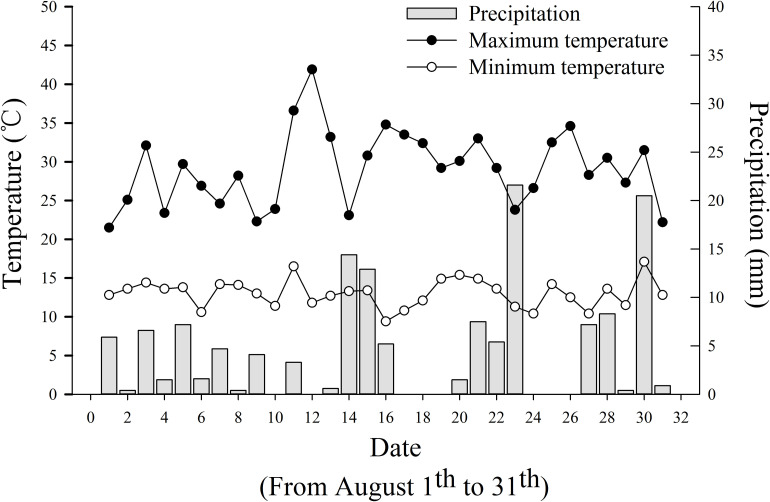
Daily precipitation, the highest and lowest temperatures from August 01 to 31 in Jianji village, Laojun Mountain Town, Jianchuan County.